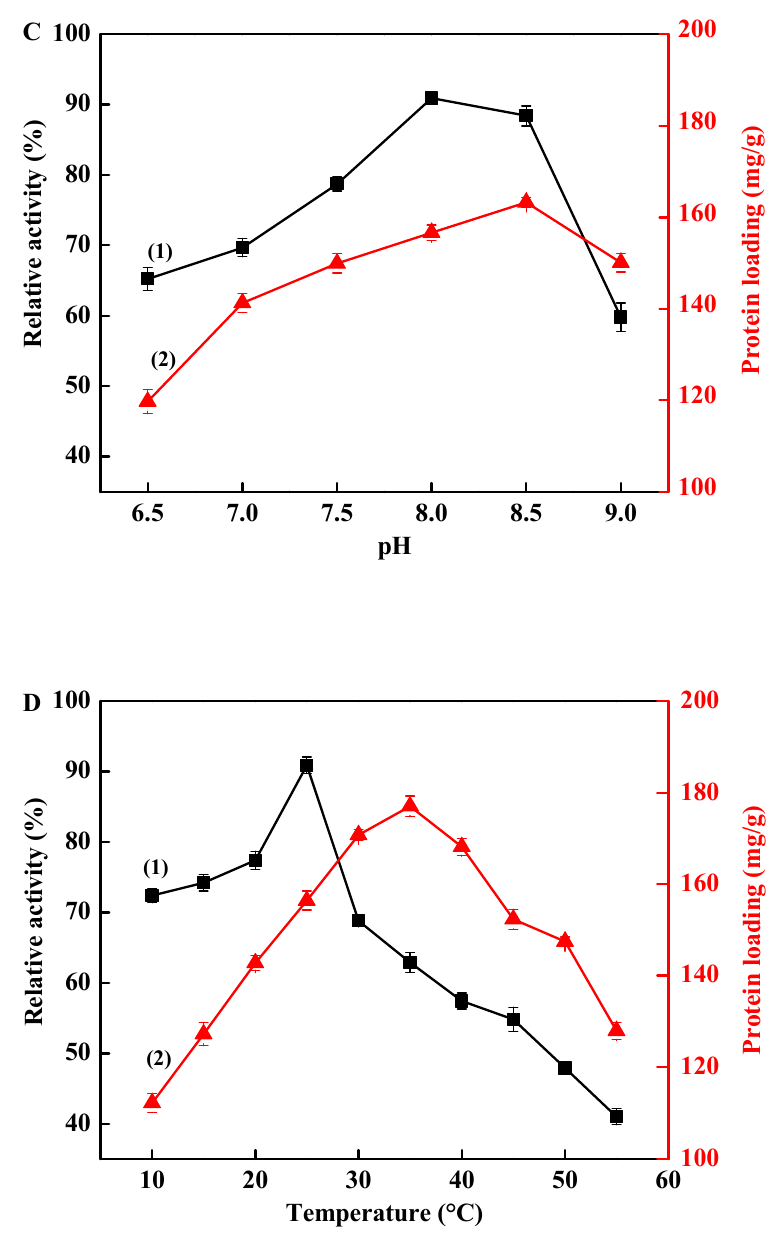
Figure 4. Effect of immobilization conditions on activity recovery ( 1 ) and protein loading ( 2 ). ( A ) Effect of enzyme-support ratio (12 mL phosphate buffer (50 mM, pH 8.5) containing 0.4 g Fe 3 O 4 @PDA, different amount of TLL, 25 °C, 10 h); ( B ) Effect of immobilization time (12 mL phosphate buffer (50 mM, pH 8.5) containing 0.4 g Fe 3 O 4 @PDA, 2.4 mL TLL, 25 °C, different immobilization time); ( C ) Effect of immobilization pH (12 mL phosphate buffer (50 mM, pH 6.5–9.0) containing 0.4 g Fe 3 O 4 @PDA, 2.4 mL TLL, 25 °C, 4.0 h); ( D ) Effect of immobilization temperature (12 mL phosphate